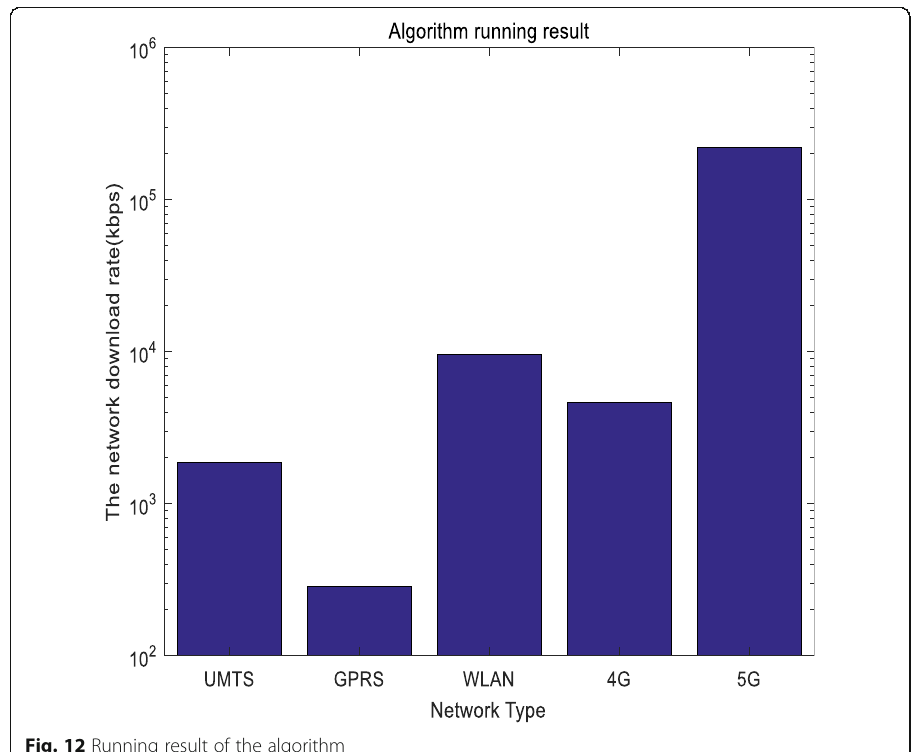
Fig. 12 Running result of the